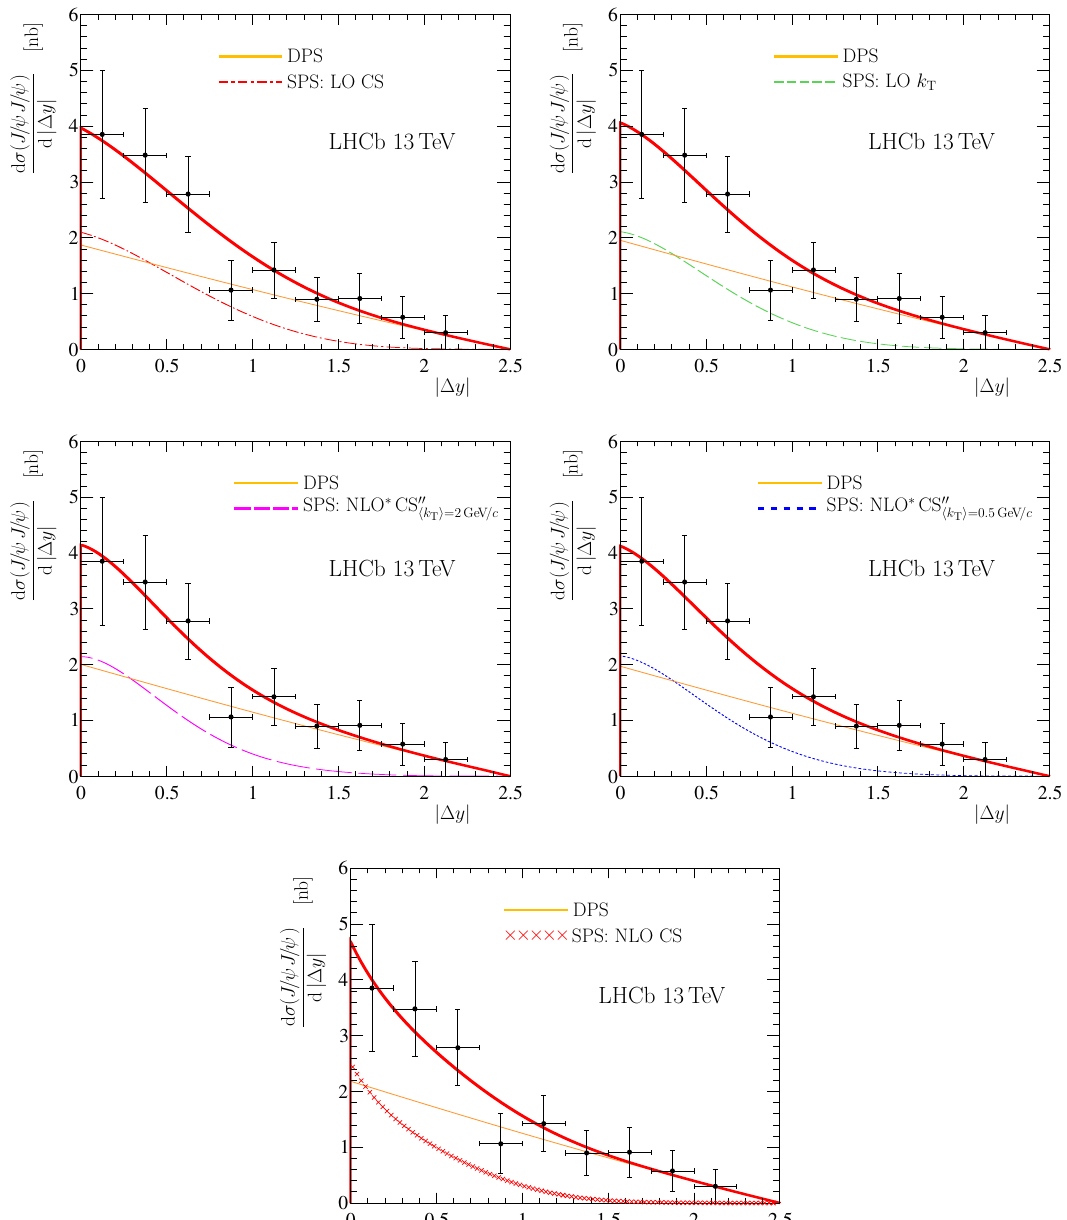
Figure 11. Result of templated DPS (cid:12)t for d (cid:27) ( J= J= ) . The (black) points with error bars represent d j (cid:1) y j the data. The total (cid:12)t result is shown with the thick (red) solid line and the DPS component is shown with the thin (orange) solid line.